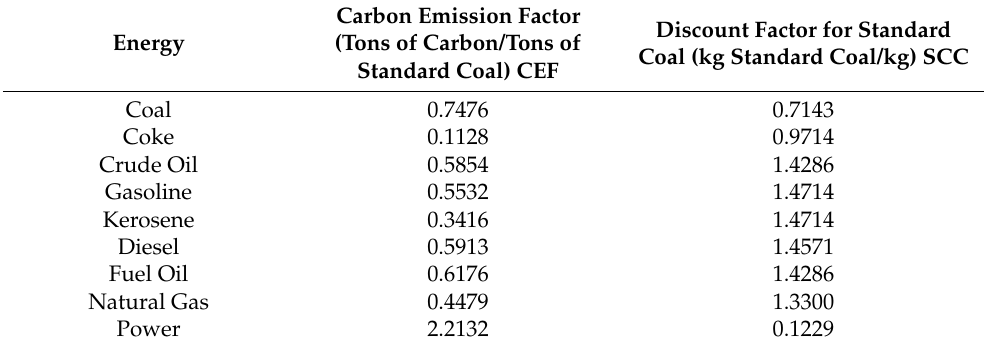
Table 1. Carbon emission factors and standard coal conversion factors of nine energy sources.